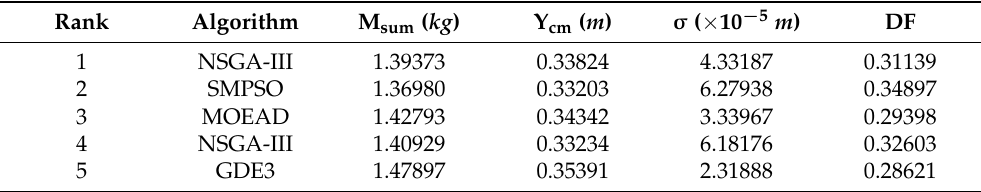
Table 5. The top five scoring solutions correspond to the four design objective values based on Equations (13)–(16), respectively.